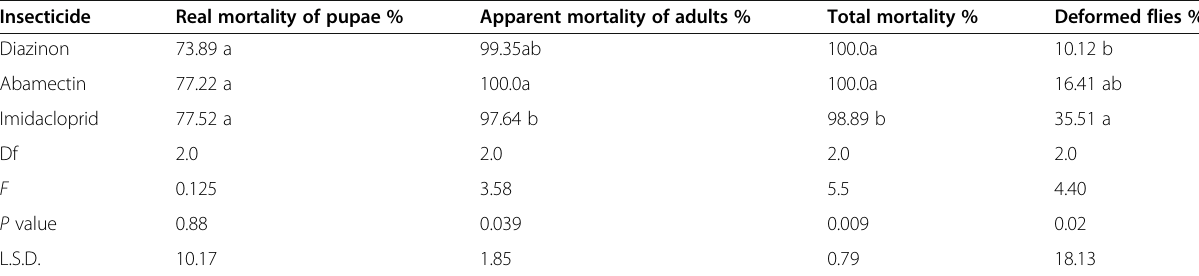
Table 4 The real and apparent mortalities, and deformed flies percentages of the peach fruit fly, Bactrocera zonata , treated with pesticides in pupal stage